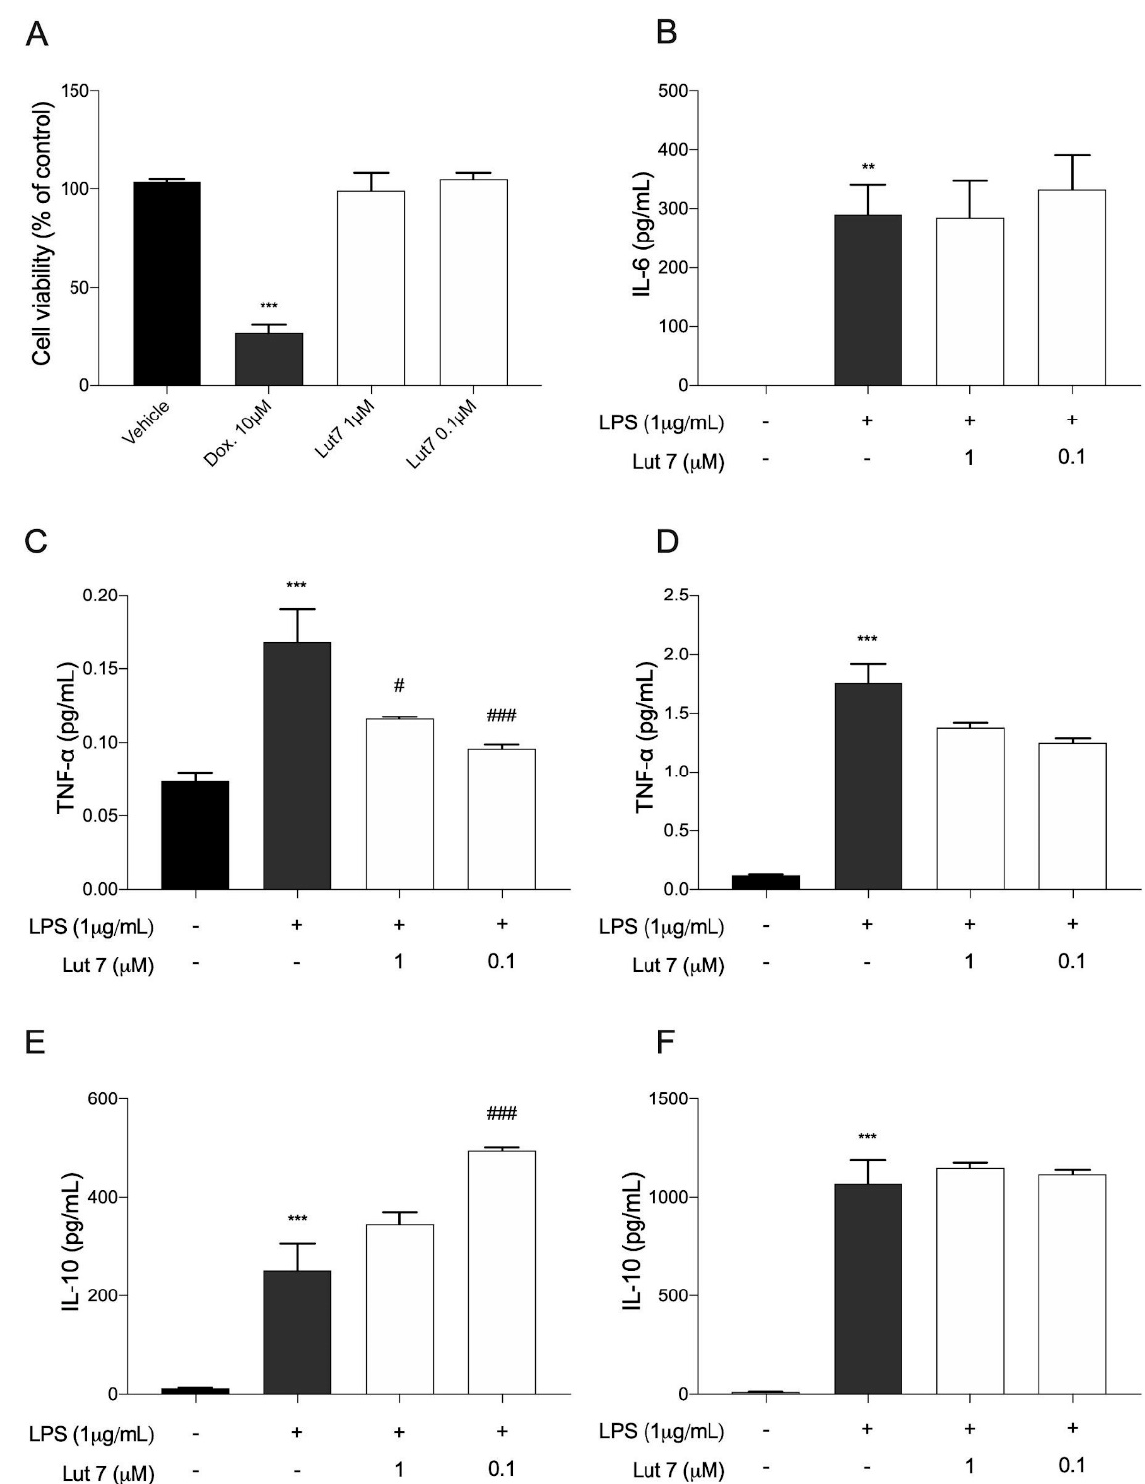
Figure 5. ( A ) Cytotoxicity of luteolin-7-O-glucoside (Lut7) on RAW264.7 cells viability after treatment for 24 h; ( B ) IL-6 levels were determined after 12 h of treatment; ( C ) TNF- α levels were determined after 3 h and ( D ) 24 h of treatment. IL-10 levels were estimated ( E ) after 24 h; and ( F ) 48 h of treatment. The values represent the mean ± SEM of at least three experiments carried out in triplicate. ** p < 0.01; *** p < 0.001; (vs. control); ### p < 0.001 and # p < 0.05 (vs. LPS). Doxorubicin was used as positive control; DMSO 0.1% was used as vehicle.